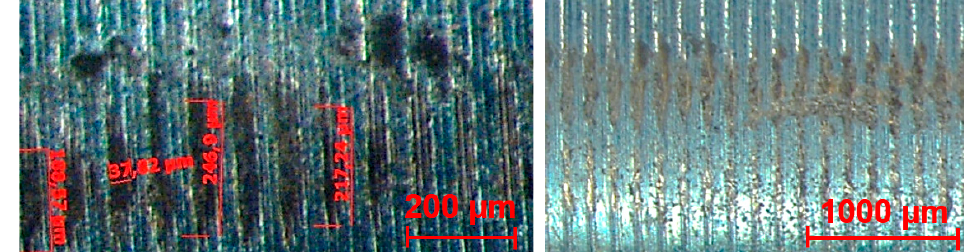
Figure 18. Sample No. 49—10 × magnification—5 × 10 3 cycles, 5 N load ( left ); Sample No. 13—20 × magnification—5 × 10 3 cycles 5 N ( right ).